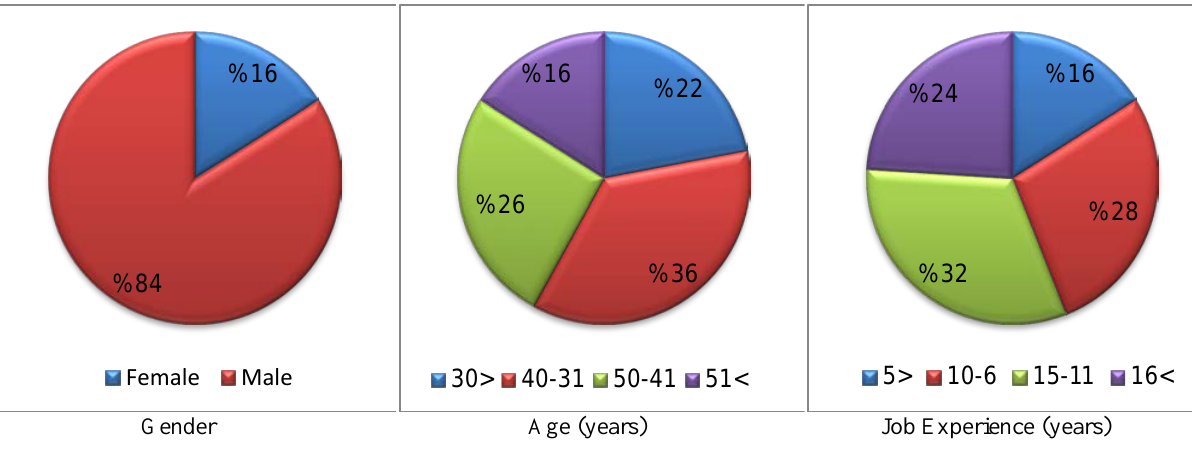
Fig. 2. Personal characteristics of the questionnaire